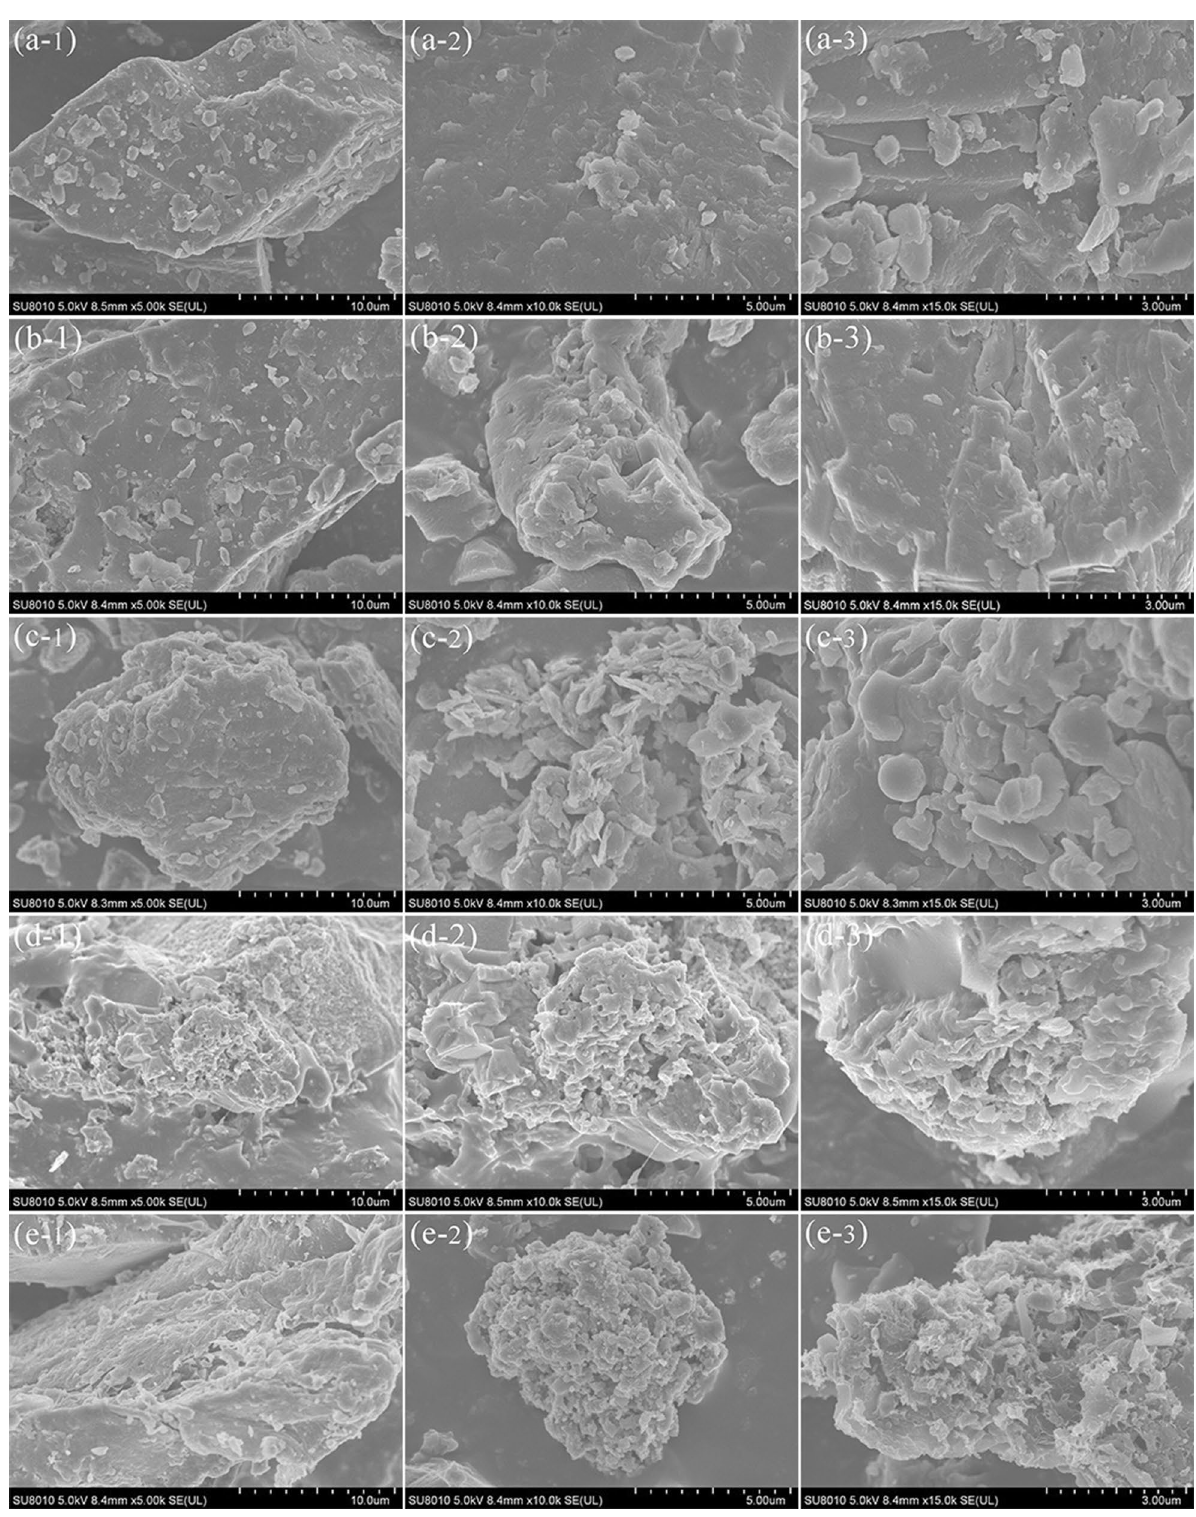
Figure 3. SEM images of the coal sample with particle sizes of 0.15–0.18 mm before and after